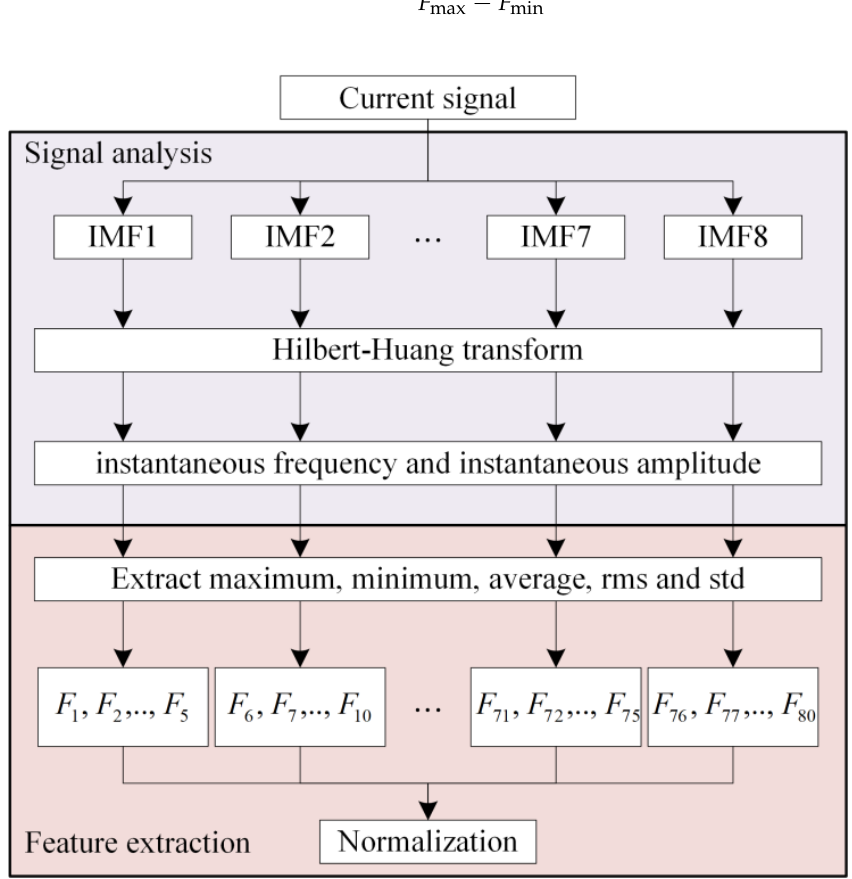
Figure 3. The structure of signal analysis and feature extraction.